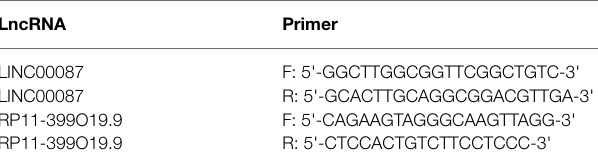
TABLE 2 | Primer sequences of LINC0008 and